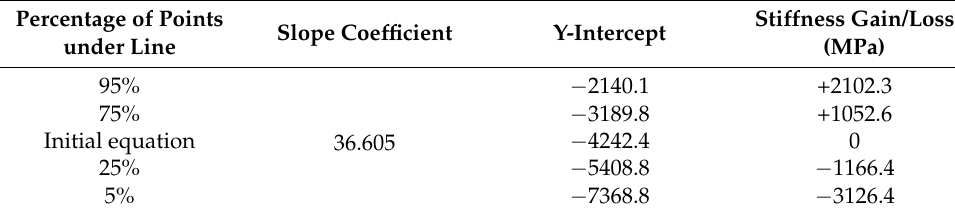
Table 2. Pollet linear regression variants.